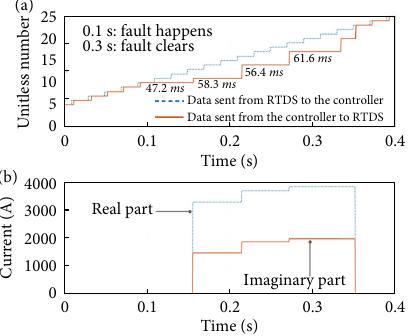
Fig. 8 Results for single-phase-to-ground faults with optimization-based AFM. ( a ) Timestamp signals are sent between RTDS simulators and the con- troller. ( b ) microgrid 1’s phase currents are sent from the controller to RTDS